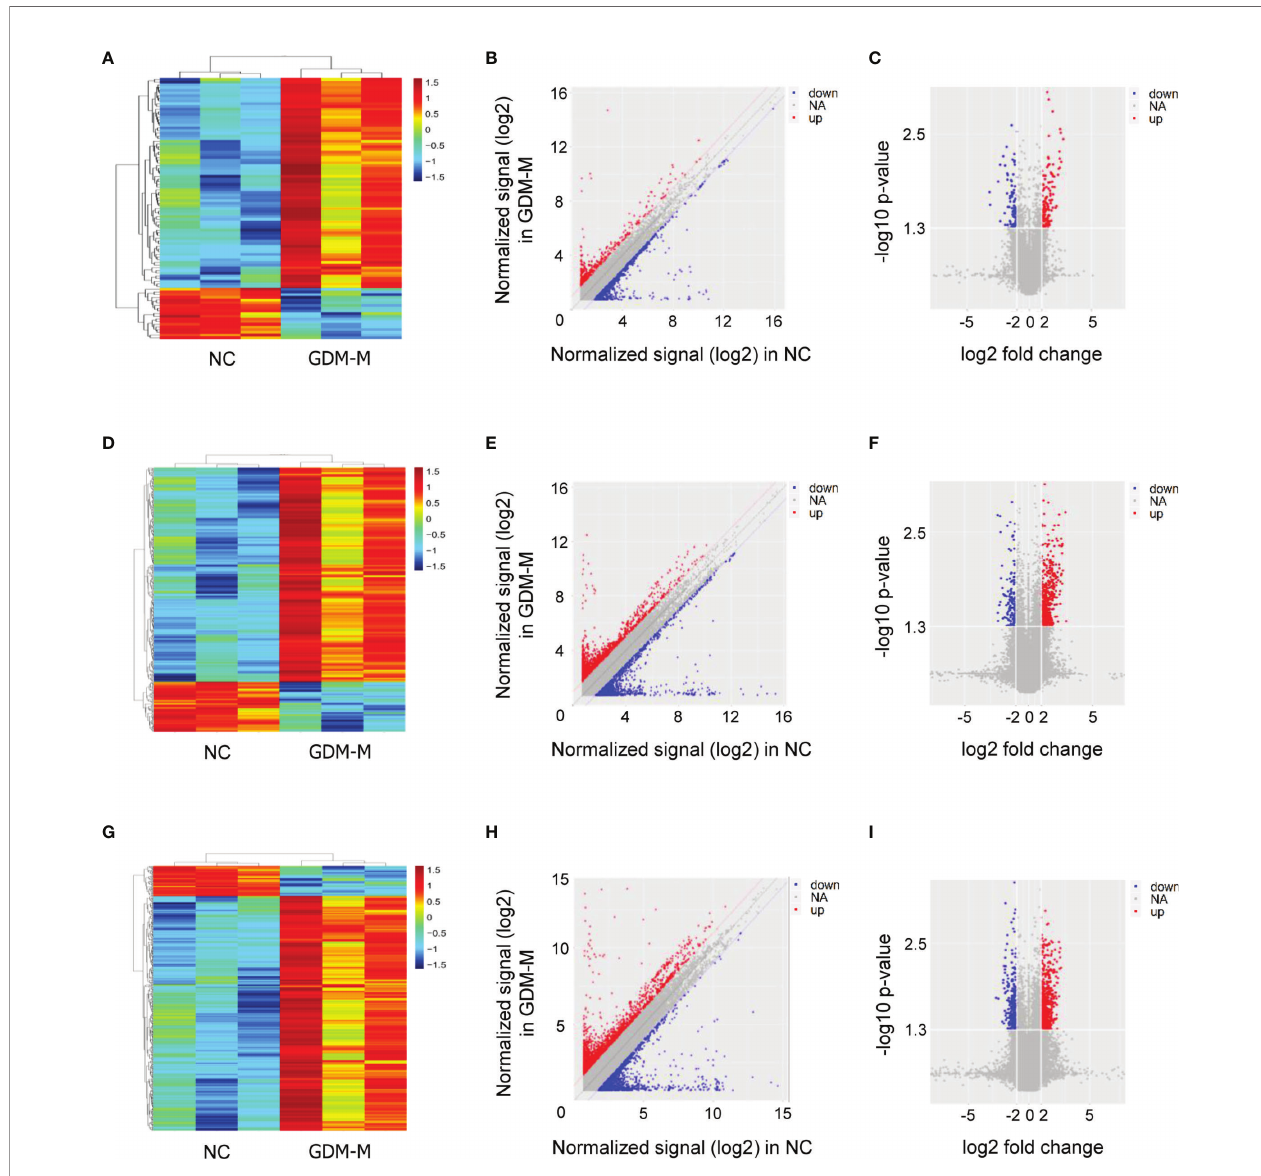
FIGURE 1 | Exosomal RNA expression pro fi les in cord blood between patients with GDM-M and controls (NC). (A – C) Cluster analysis, scatter plots, and volcano plots for mRNA. (D – F) Cluster analysis, scatter plots, and volcano plots for lncRNA. (G – I) Cluster analysis, scatter plots, and volcano plots for circRNA. GDM-M, gestational diabetes mellitus and macrosomia; mRNA, messenger RNA; lncRNA, long non-coding RNA; circRNA, circular